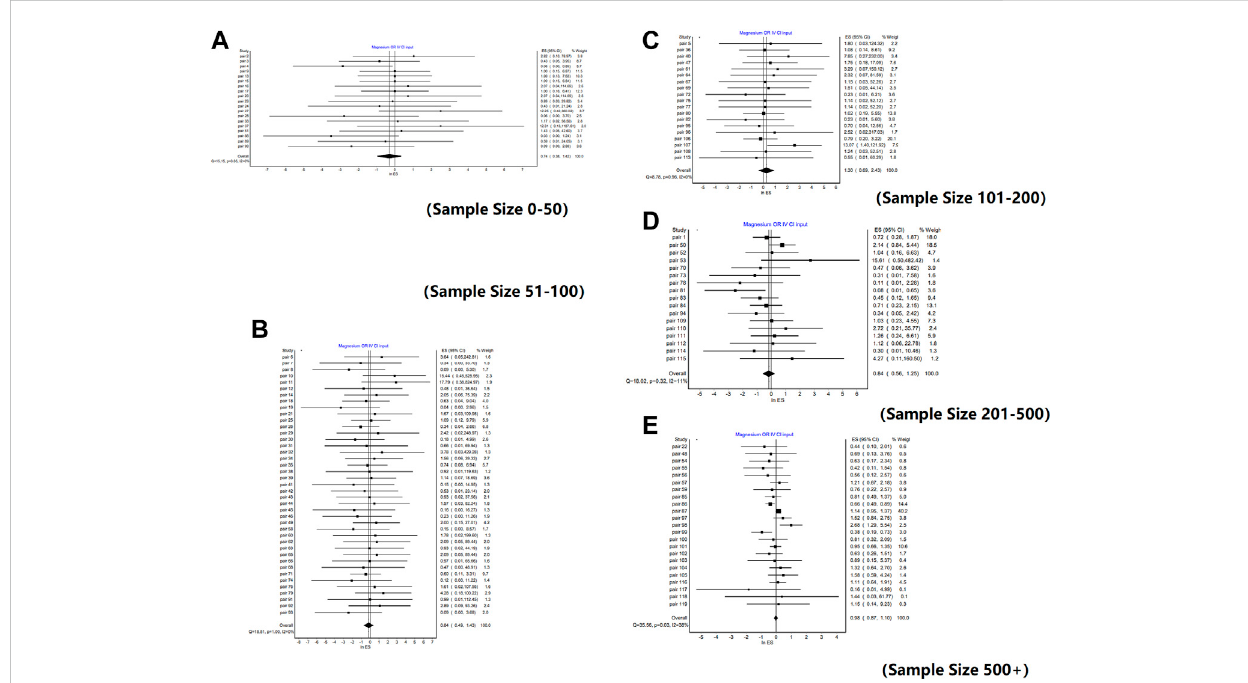
Forest plots of lnROR by sample size. [ (A) Forest plot of lnROR for pairs with sample sizes between 0 and 50; (B) Forest plot of lnROR for pairs with samplesizesbetween51and100; (C) ForestplotoflnRORforpairswithsamplesizesbetween101and200; (D) ForestplotoflnRORforpairswithsample sizes between 201 and 500; (E) Forest plot of lnROR for pairs with sample sizes, ore than 500].